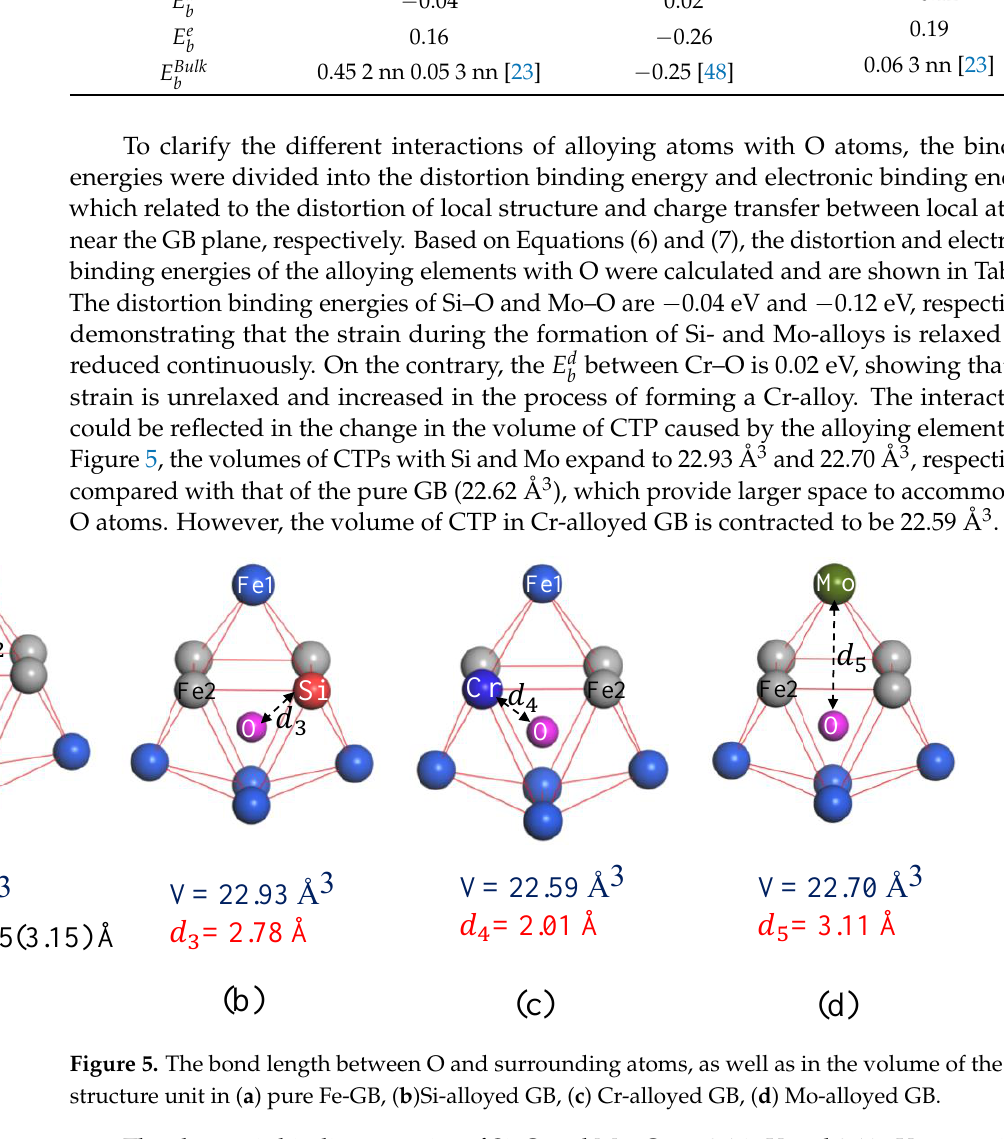
Figure 5. The bond length between O and surrounding atoms, as well as in the volume of the CTP structure unit in ( a ) pure Fe-GB, ( b )Si-alloyed GB, ( c ) Cr-alloyed GB, ( d ) Mo-alloyed GB. The electronic binding energies of Si–O and Mo–O are 0.16 eV and 0.19 eV, respectively, while the E e for Cr–O is − 0.26 eV. The positive values indicate electronic repulsion between b Si/Mo and O atoms, and the attractive interaction between Cr and O atoms. The electronic interactions between O and the alloying atoms are related to their electronegativity. The difference in electronegativity between O (3.44) and Cr (1.66) is greater than that between O and Fe (1.83), indicating a stronger ionic bond between O and Cr. On the contrary, the smaller difference in electronegativity between O (3.44) and Si (1.9) or Mo (2.16) presents a weaker interaction compared with that between O and